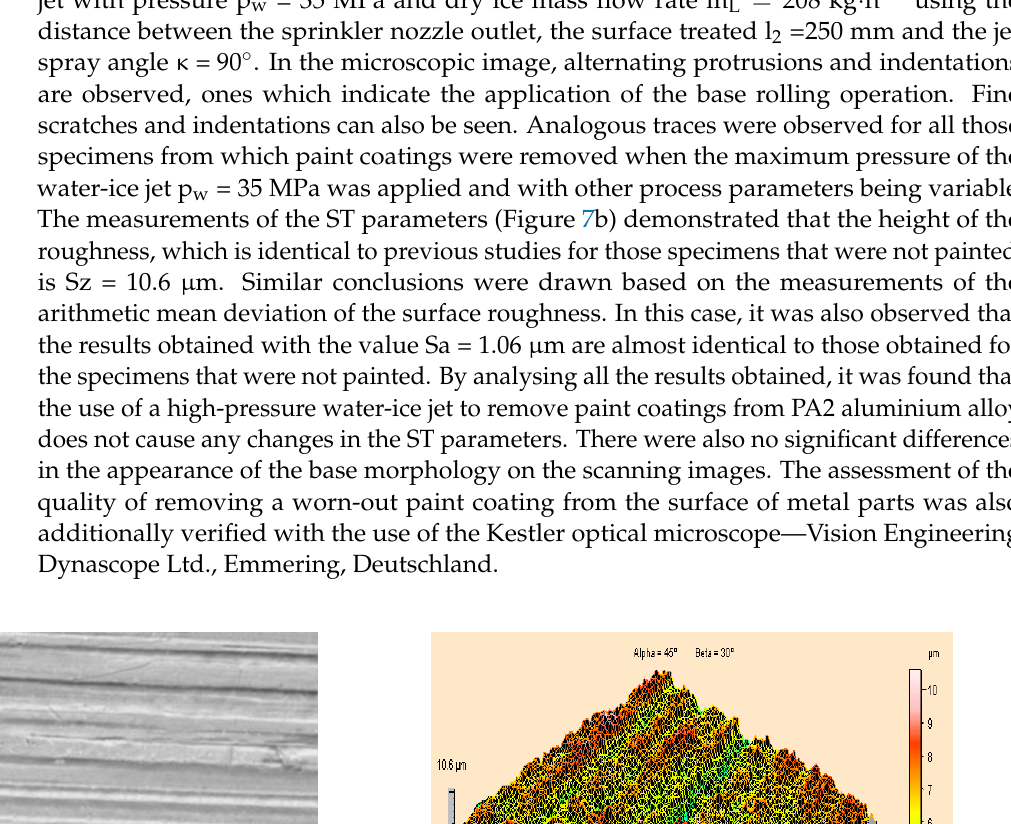
( b ) Figure 6. Surface topography of a PA2 aluminium alloy specimen prior to the application of paint coating and before high-pressure water-ice jet treatment: ( a ) Scanning electron microscope image (400×magnification); ( b ) Isometric image. Figure 7 presents the results of surface topography observations under a scanning electron microscope and of the measurements of ST parameters of PA2 aluminium alloy